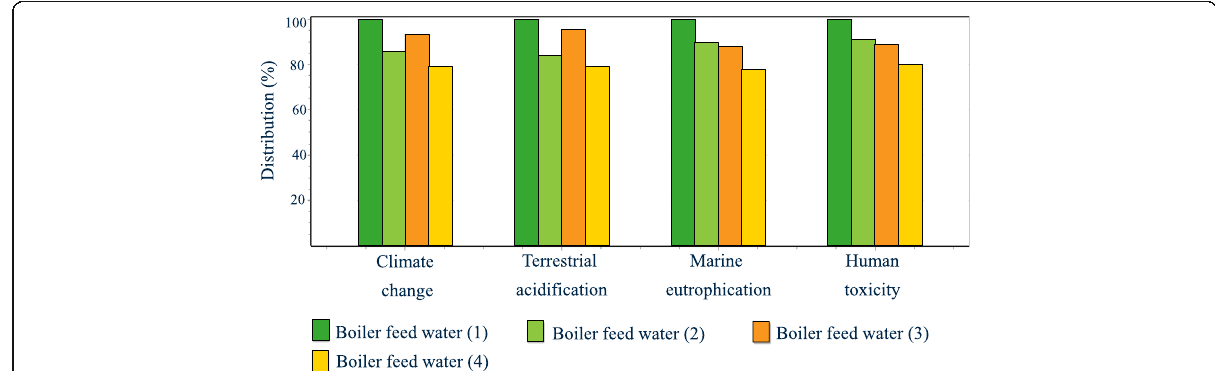
Fig. 4 Contribution of boiler feed water produced by each combination in integrated membrane-filtration system towards life cycle impact